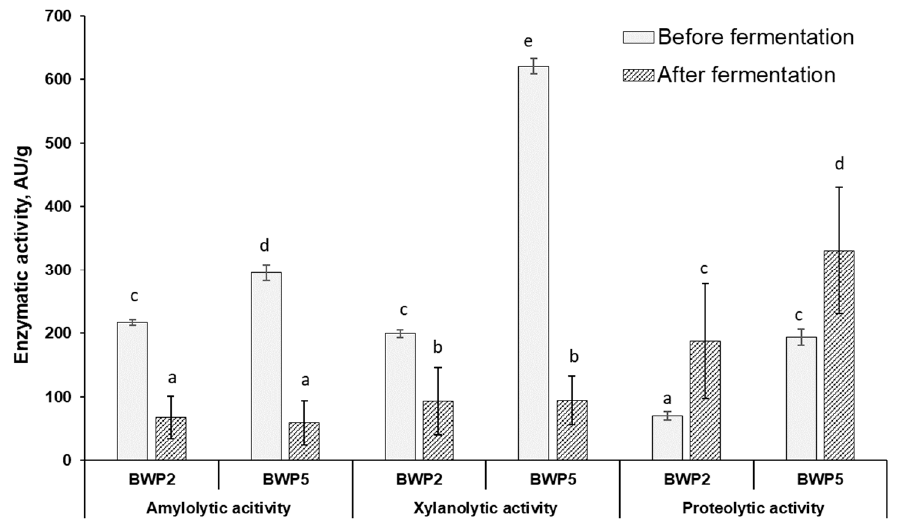
Figure 3. Changes in enzymatic activities (amylolytic, xylanolytic, and proteolytic) during fermen- tation in barley wholemeal samples with the lowest (BWP2) and highest (BWP5) contamination (AU—activity units). a–e Mean values denoted with different letters indicate significantly different values between the columns ( p ≤ 0.05).